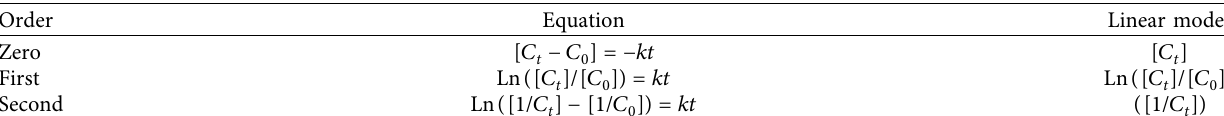
Table 5: Kinetics